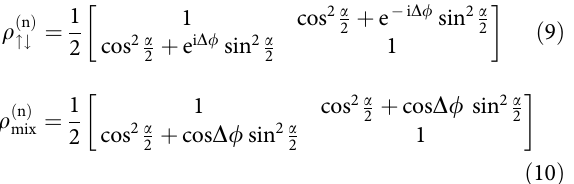
Fig. 3a was measured with j ¼ 0 of the final memory p /2-pulse